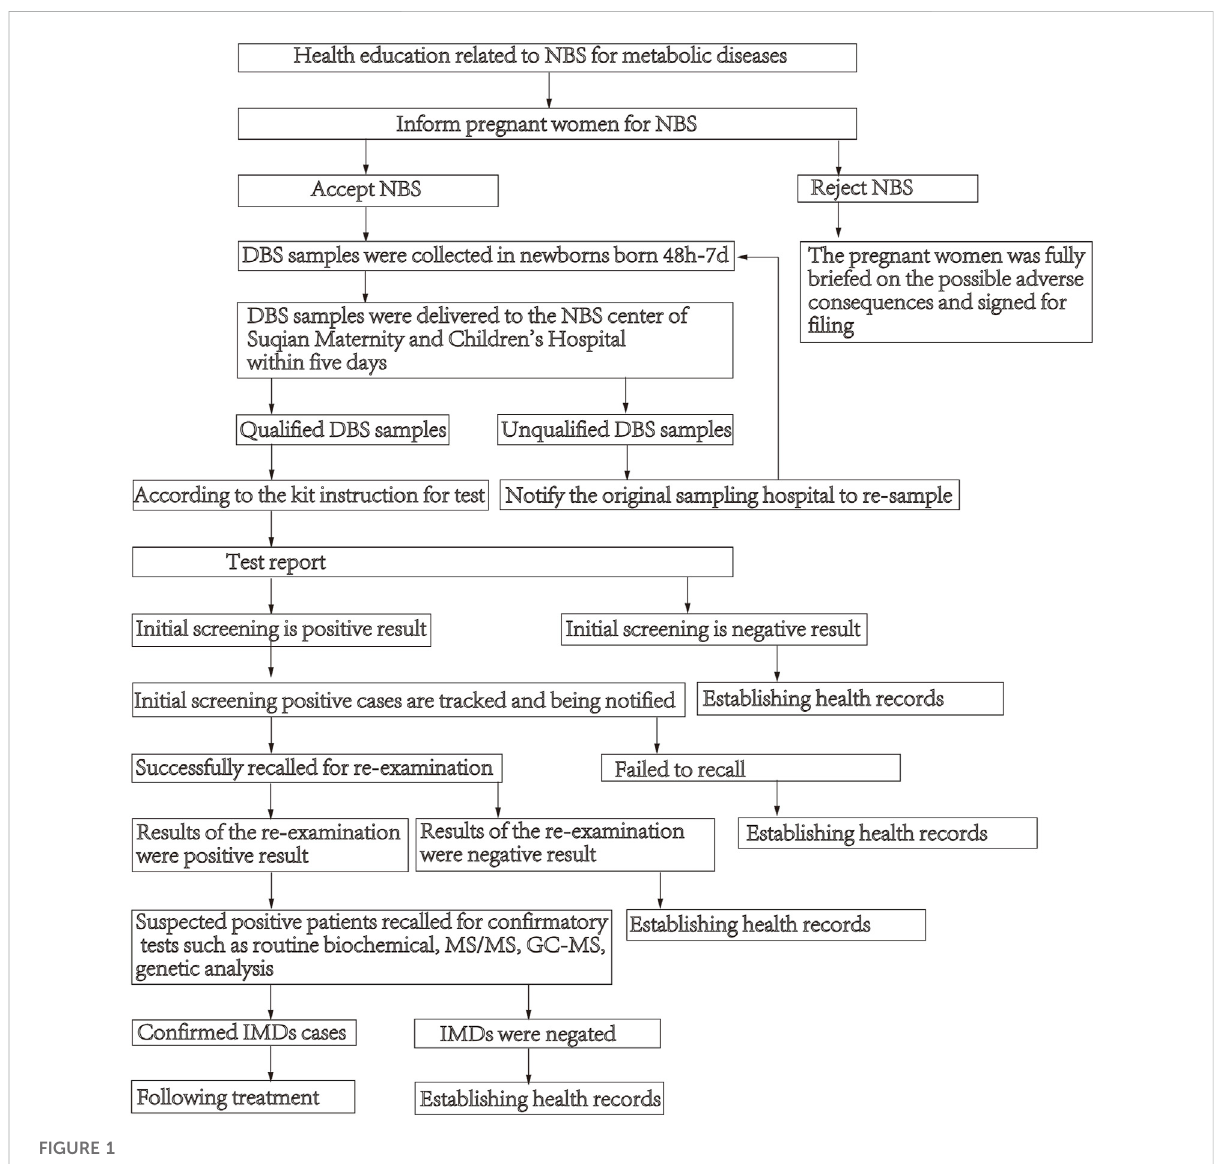
FIGURE 1 Flowchart of newborn